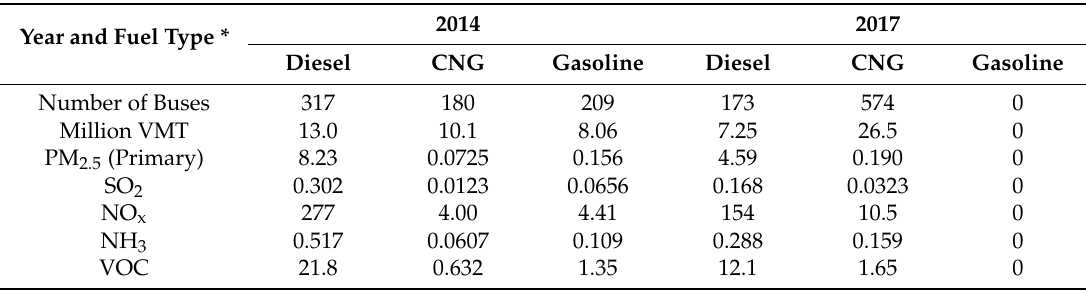
Table 1. Number of buses, vehicle mile traveled (VMT), and emissions (tons/year) of the RTC buses by fuel type for 2014 and